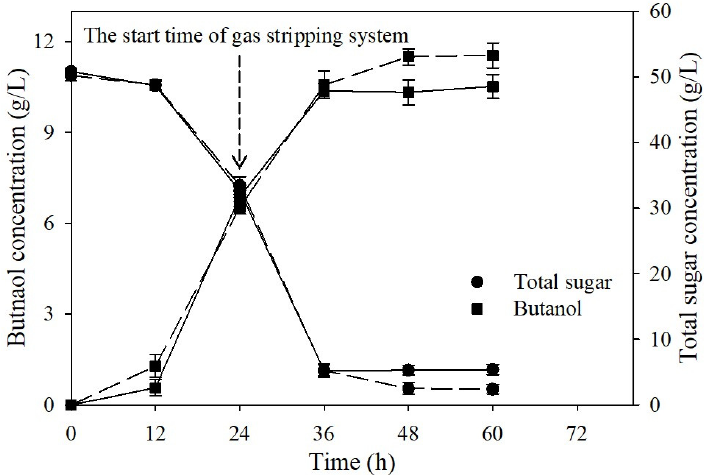
Figure 8. Comparison of butanol production and sugar consumption from sugarcane molasses us- ing an internal loop gas-lift bioreactor coupling with a gas stripping system (dashed lines) and with- out gas stripping (solid lines).